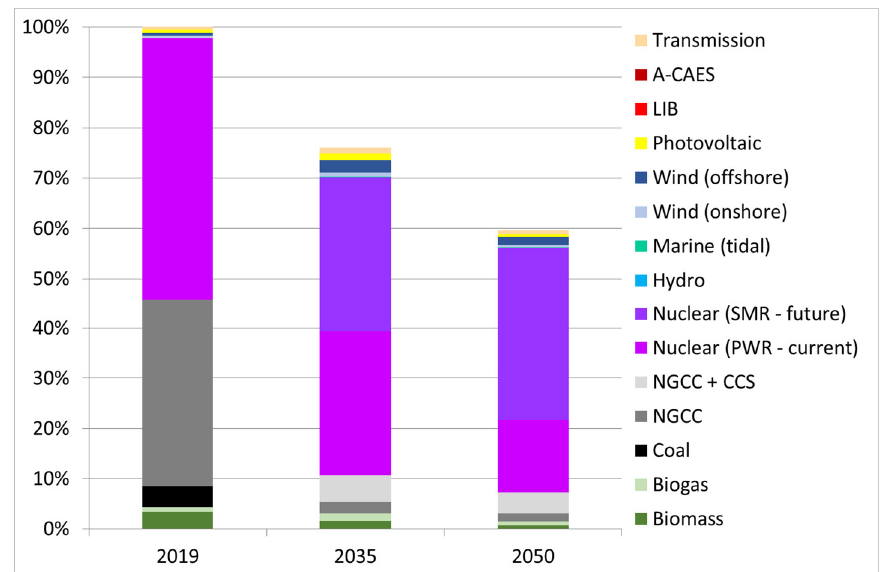
Figure 12. Non-renewable Cumulative Energy Demand (nr-CED) per unit of electricity delivered by the UK grid mix (including energy storage and transmission), expressed as relative to the 2019 value (100% = 6.0 MJ oil-eq/kWh).